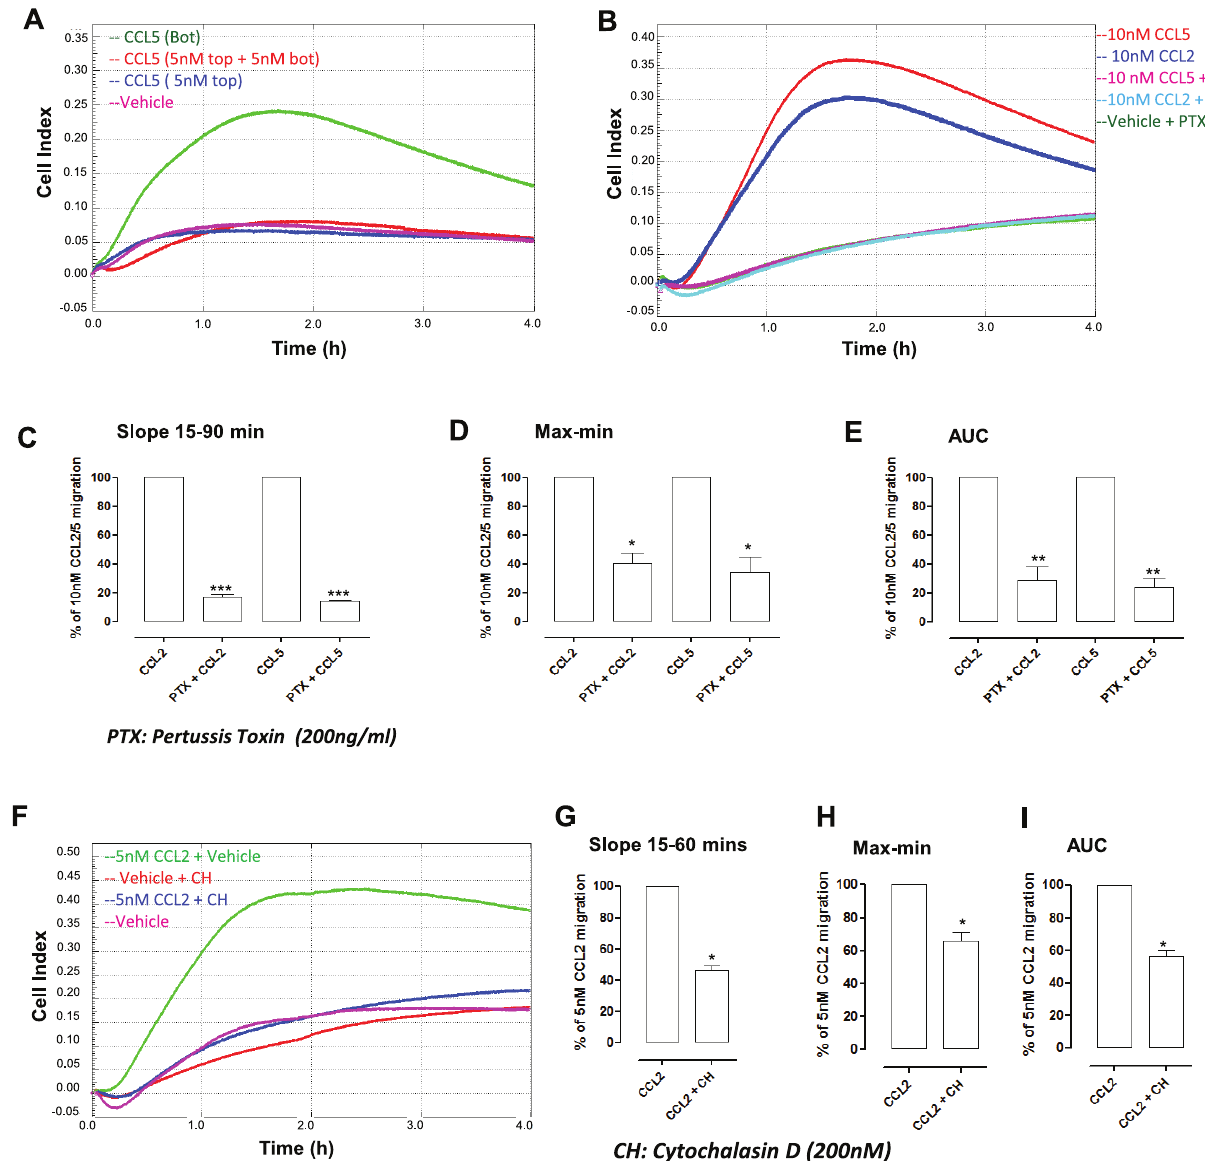
Figure 4. Demonstration of chemotaxis and its inhibition by Pertussis toxin (PTX) and cytochalasin D. To test that the assay was detecting true macrophage chemotaxis, rather than chemokinesis or fugetaxis, the following three conditions were tested; CCL5 added to the bottom well alone ( test chemotaxis ), equal concentrations (5 nM) of murine CCL5 added to both top and bottom wells ( test chemokinesis ) or CCL5 added to the top well alone ( test fugetaxis ) ( A ) Single trace of a single experiment with four technical replicates shows Bio-Gel elicited macrophages migrate towards murine CCL5 (green), but display no chemokinesis (red) or fugetaxis (blue). Control (pink) had chemotaxis buffer alone in the bottom well. Bio-Gel elicited macrophages were pre-incubated for 90 mins at 37 u C with PTX (200 ng/ml). ( B ) A representative trace shows that pre-treatment of Bio-gel elicited macrophages with PTX significantly inhibits chemotaxis toward both murine CCL2 and CCL5. Data are shown as a percentage of 10 nM CCL2 or CCL5 induced migration for ( C ) Slope ( D ) Max-min CI and ( E ) AUC. Data are the mean 6 SEM of three independent experiments with 3–4 technical replicates per experiment. Vehicle alone was omitted in these sets of experiments in order to have all five conditions on a single CIM-16 plate. ( F ) Bio-Gel elicited macrophages were pre-incubated for 90 mins with either 200 nM cytochalasin D, an inhibitor of F-actin polymerisation. A representative trace is shown ( F ). Data are shown as a percentage of 5 nM CCL2 induced migration for ( G ) Slope ( H ) Max-min CI and ( I ) AUC. Data are the mean 6 SEM of four independent experiments with 3–4 technical replicates per experiment. Statistical analysis was performed by one-way ANOVA and Dunnett’s multiple comparison post-test. *, p , 0.05, **, p , 0.01, ***, p , 0.01 relative to CCL2 or CCL5 alone.